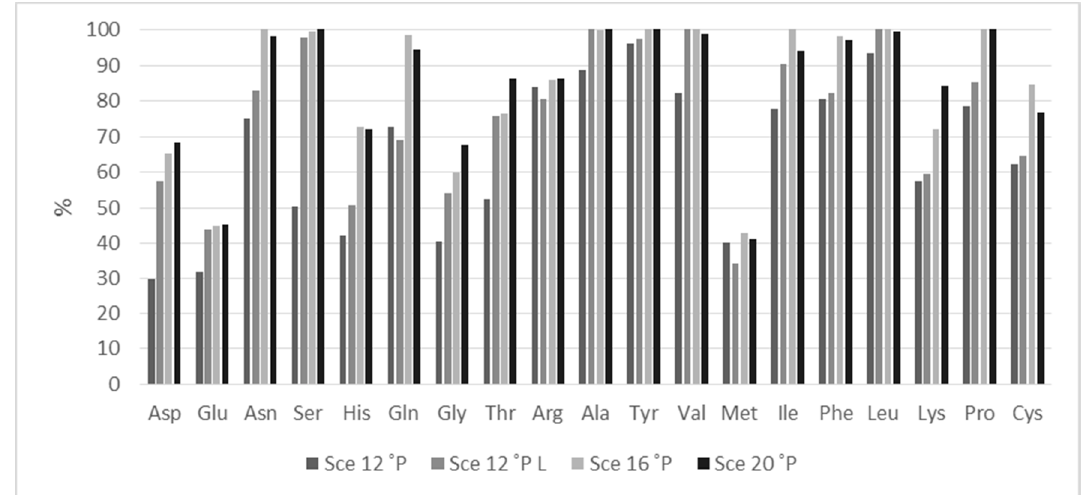
Figure 3. Percentage share of free amino acids of yeast extract (from S. cerevisiae TUM 68) protein released via autolysis; influence of original gravity (12 ˚ P, 16 ˚ P, 18 ˚ P) and time of yeast cropping (after primary fermentation vs. after cold beer lagering (L)).